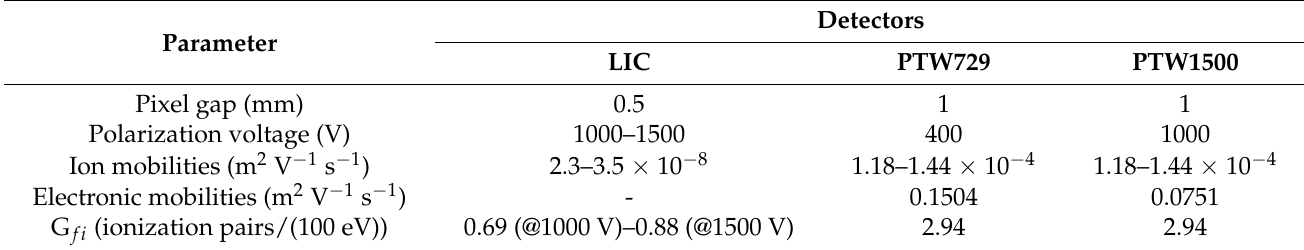
Table 1. Main characteristics and physical parameters of the simulated detectors. LIC corresponds with the isooctane-filled liquid ionization chamber presented in [13], while PTW729 and PTW1500 correspond with the pixel characteristics of the air-filled PTW “729” and “1500” arrays